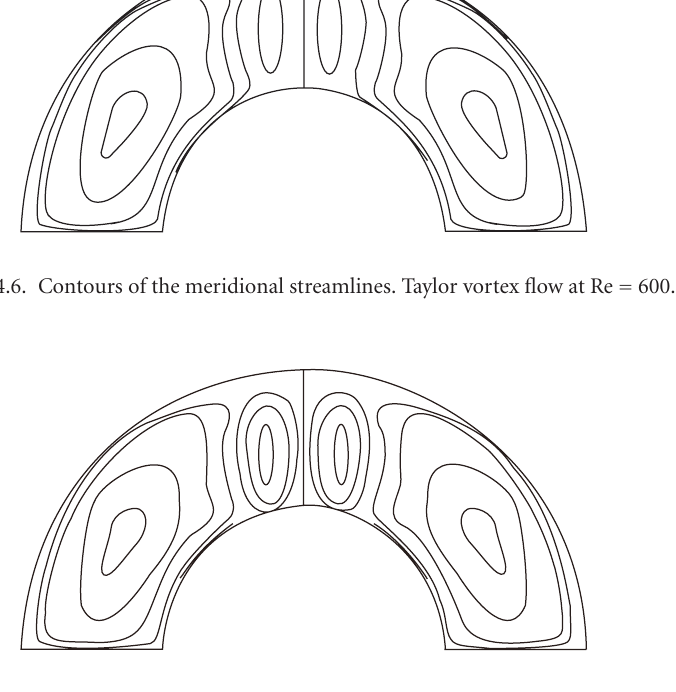
Figure 4.7. Contours of the meridional streamlines. Taylor vortex flow at Re = 600.